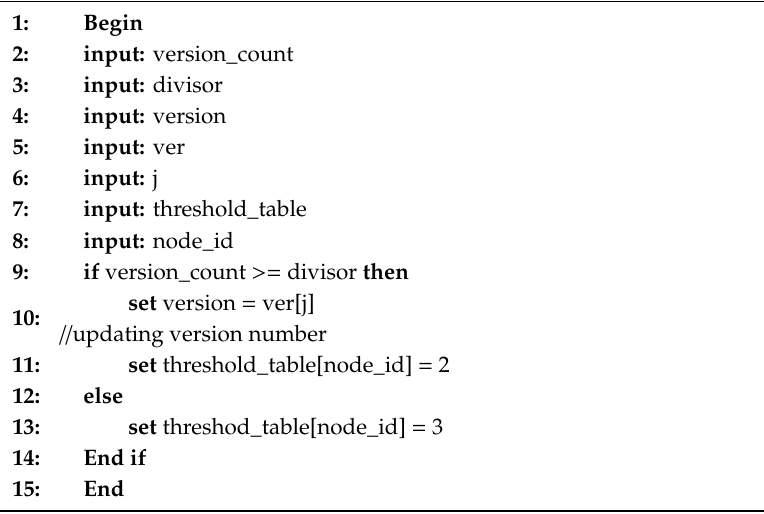
Algorithm A4. Version Number Attack